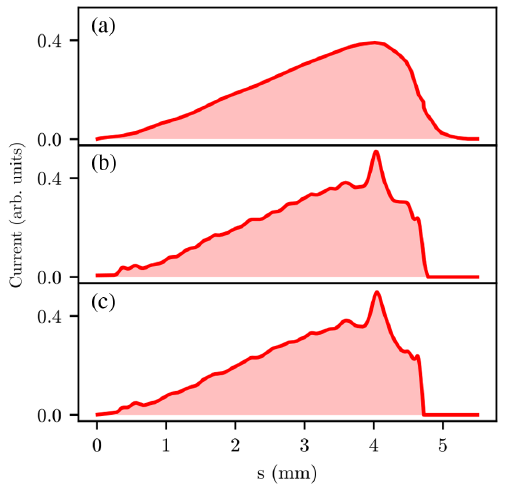
FIG. 4. (a) Normalized charge density from Ref. [20] measured with the LPS diagnostic. (b) Normalized charge density at the wake field accelerating structure reconstructed using Eq. (19) (c) Normalized charge density at the wake field accelerating structure reconstructed using